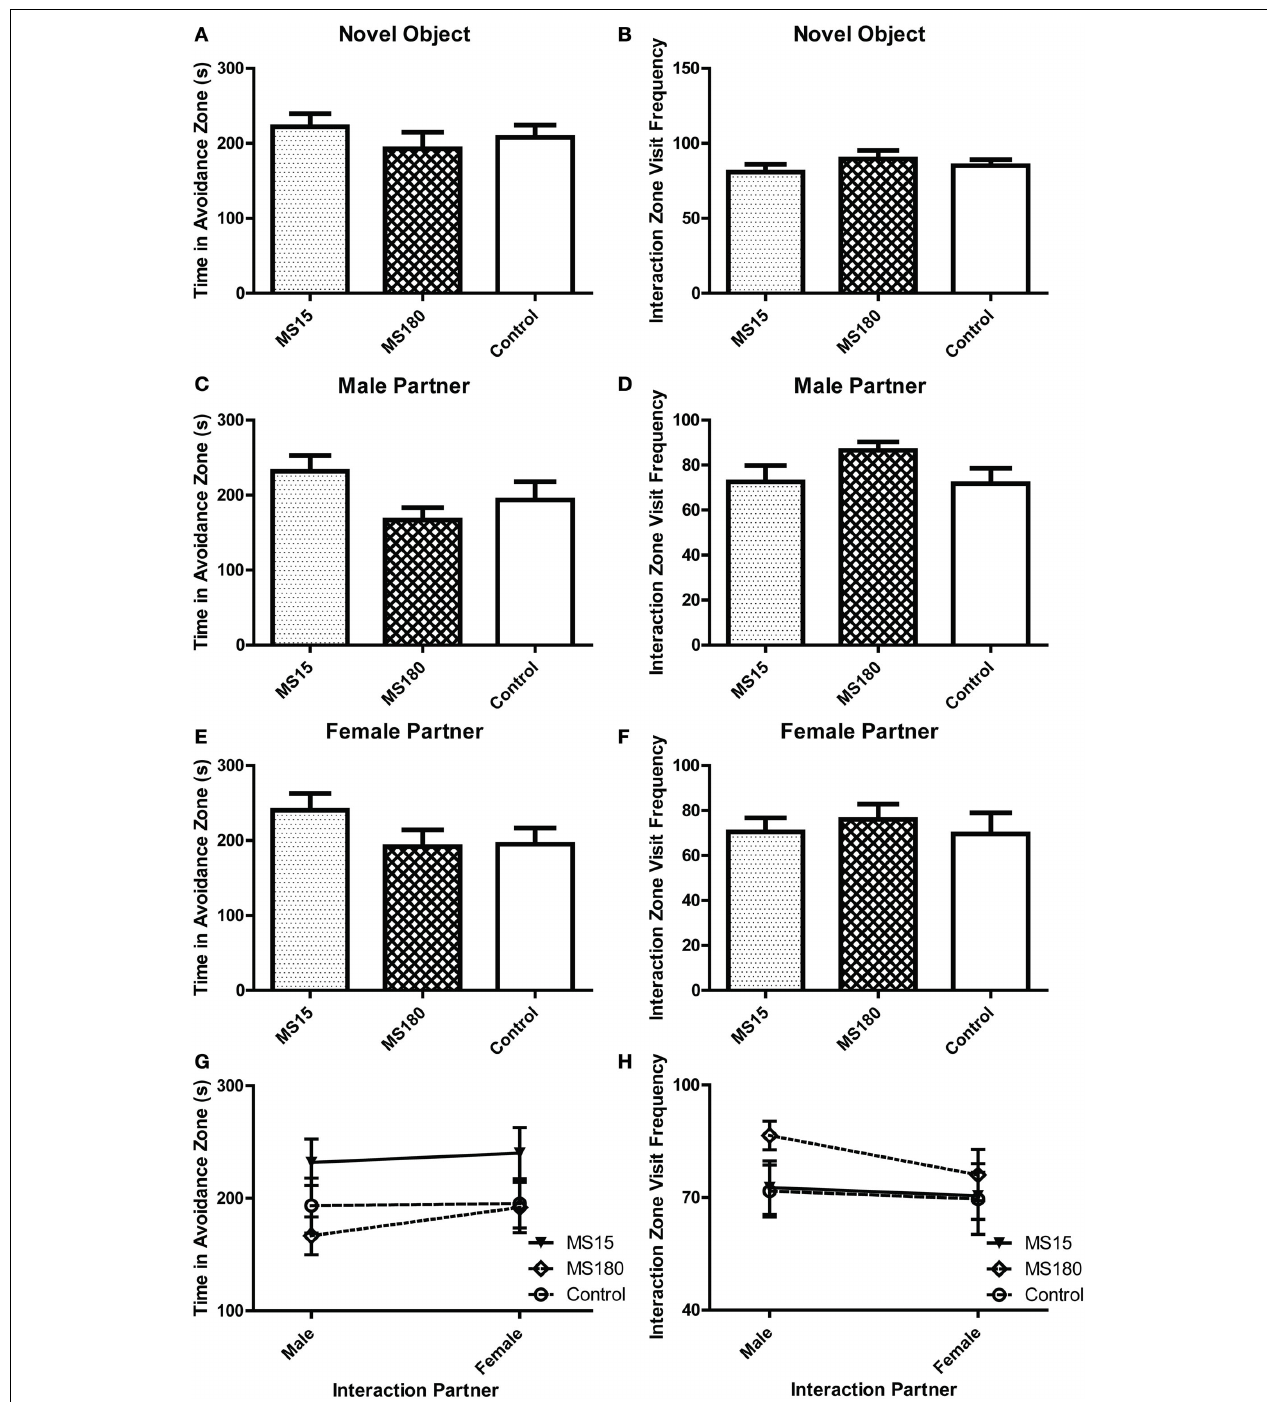
FIGURE 5 | Early-life experience does not alter WKY social interaction behavior. Social interaction behavior was examined in adult male WKY control rats as well as WKYs that were separated from their dams for 15min (MS15) or 180min (MS180) per day during the first 2 weeks of life. During the three test sessions, animals encountered a novel object (test day 1), a novel male stimulus rat (test day 2), or a novel female stimulus